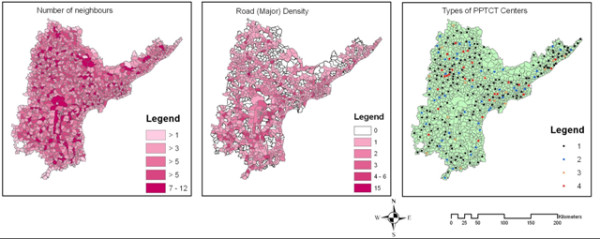
layersB. Layers of the explanatory variables generated for establishing spatial relations.